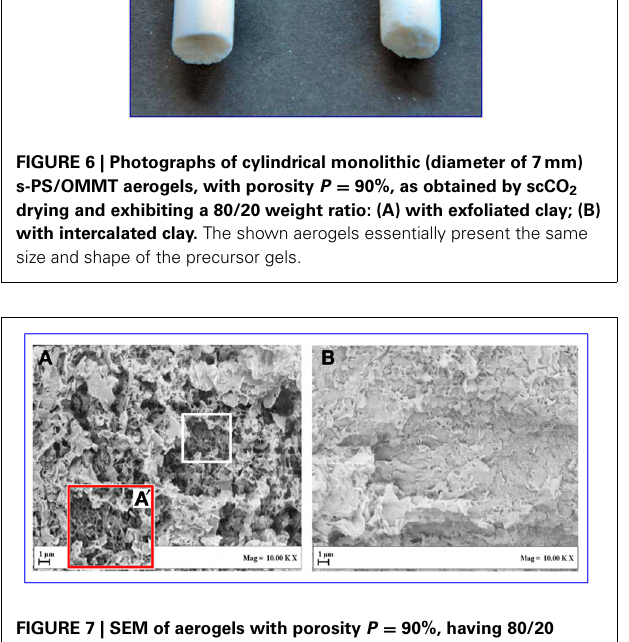
FIGURE 8 | Schematic representation of the sPS/exfoliated-OMMT